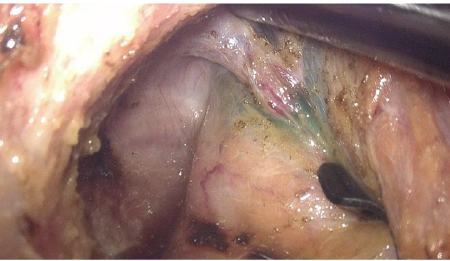
Table 1. Patient demographics, clinicopathology, and ICG fluorescent detection site. Figure 1. ICG stained rectal wall along with the middle rectal vessels running through the rectum.